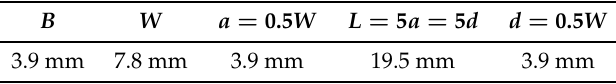
Table 4. Required dimensions of mode I specimens.